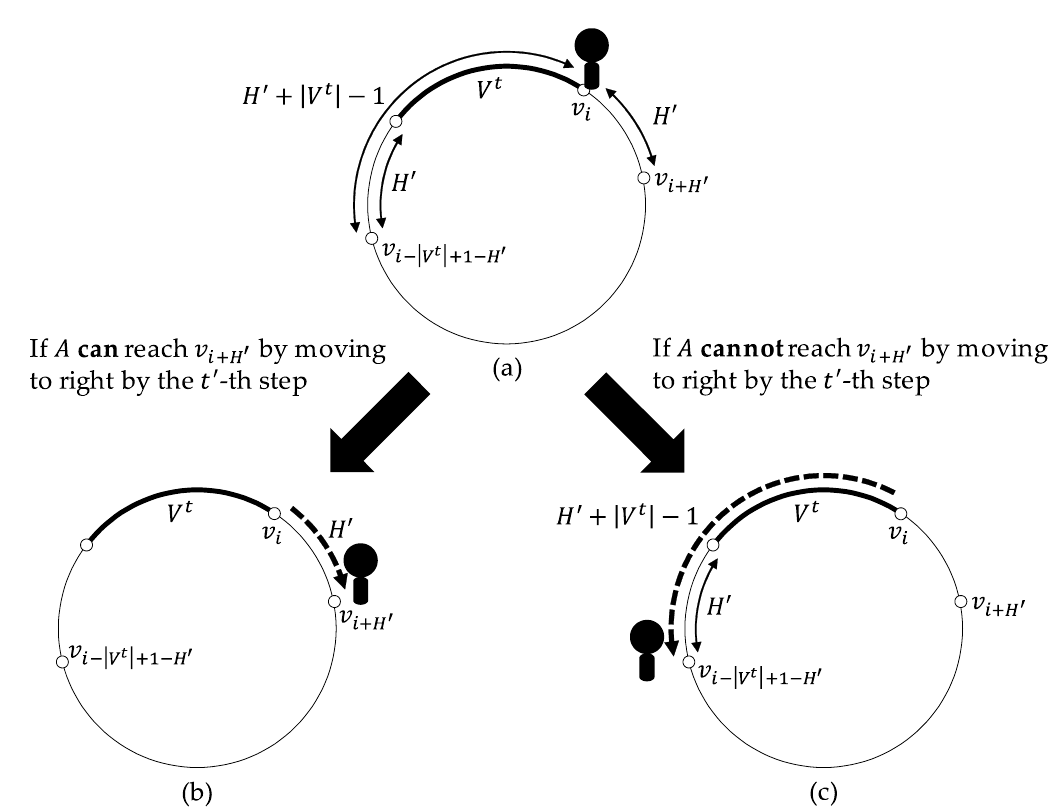
Figure 2. The moves of A by E XP H ( t , v i ) where t (cid:48) = t + 2 H (cid:48) + | V t | − 2 in the case where v i is the right extremity of V t . ( a ) At the start of E XP H ( t , v i ) , A exists on v i . ( b ) If A can reach v i (cid:48) + H by moving to right by the t (cid:48) -th step, A moves to right and reaches v i + H (cid:48) by the t (cid:48) -th step. ( c ) Otherwise, A moves to left and reaches v i −| V t | + 1 − H (cid:48) by the t (cid:48) -th